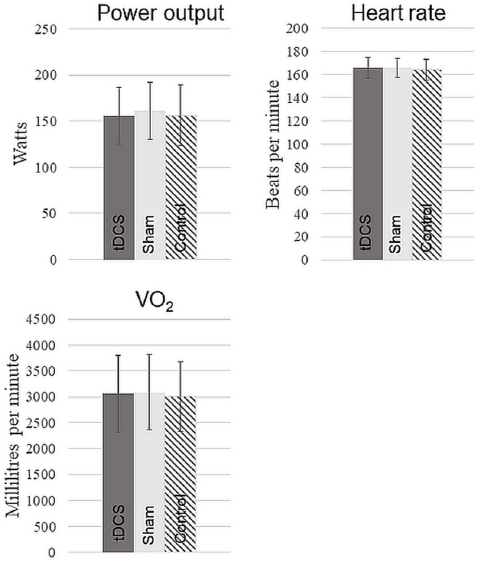
Fig 3. Power output, heart rate, and oxygen consumption (VO 2 ) during the RPE-clamp test. The dark grey bars represent the a-tDCS condition, the light grey bars represents the sham condition, and the striped bars represents the control condition. The error bars represent the standard deviation. N = 20.